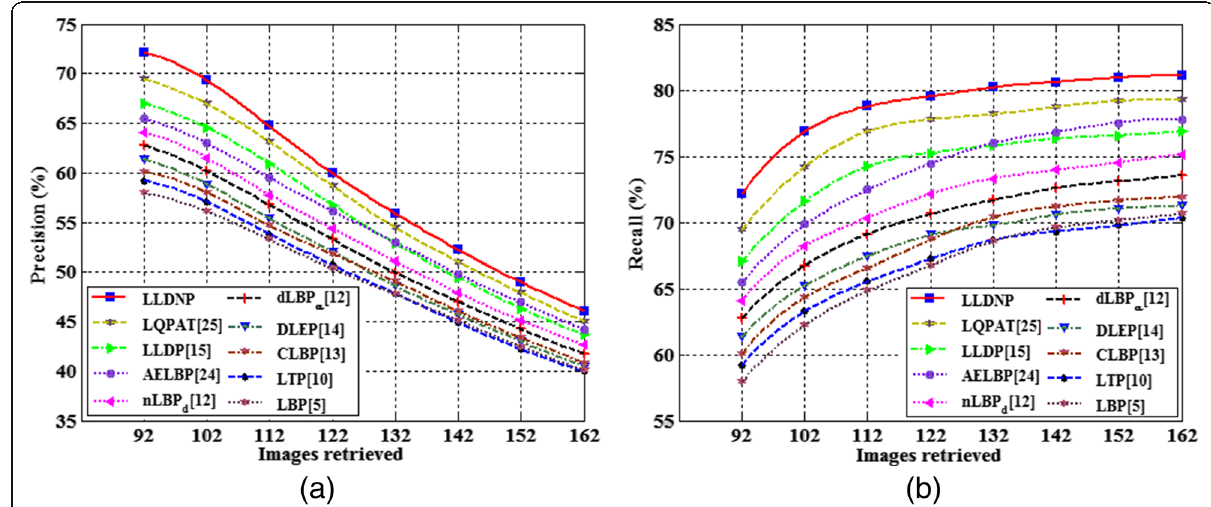
Fig. 13 Comparison of proposed method with other existing methods in terms of a precision and b recall on CUReT database. The performance of existing methods and proposed LLDNP in terms of precision and recall is analyzed. Initially, we retrieved 92 images, then incremented by 5 reaching up to 162. The proposed LLDNP shows improved performance than the other existing methods on CUReT database